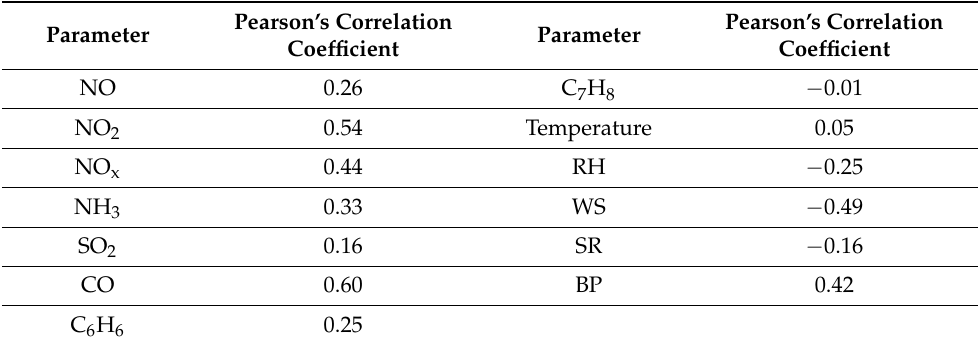
Table 5. Correlation of PM 2.5 with air pollutants and meteorological parameters. Pearson’s Pearson’s Correlation Parameter Parameter Coefficient